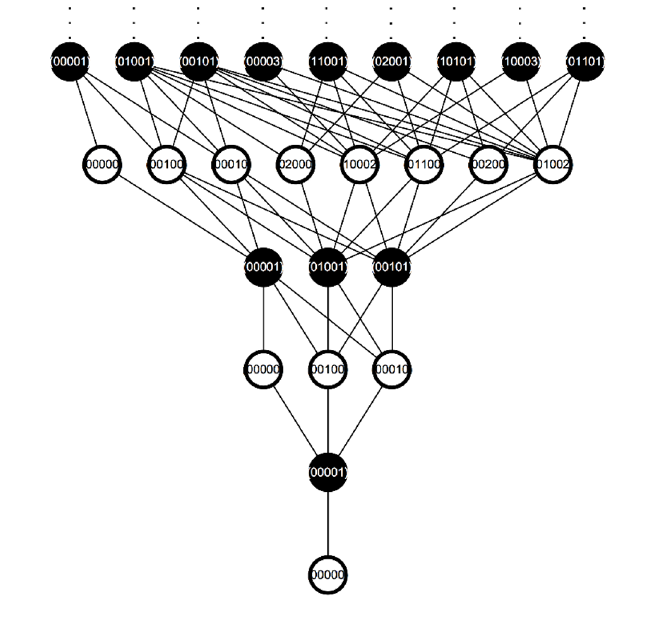
graviton and gauge 3-form (as well the conformal gravitino at one higher level) show up, imply V is a super(cid:12)eld limit of M-Theory, with V being a supergravity prepotential super(cid:12)eld or possibly a semi-prepotential super(cid:12)eld. Conjecture # 2: Under the branchings of su (32) (cid:27) so (10) and su (32) (cid:27) so (4) respectively,